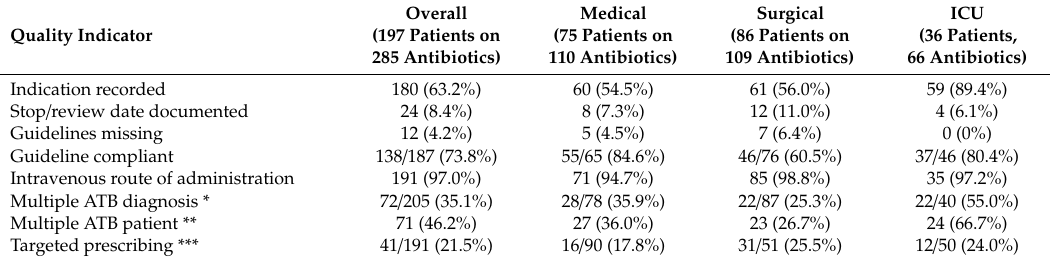
Table 3. Prevalence of key quality indicators for antibiotic prescribing (all patients, ATC code = J01; %).